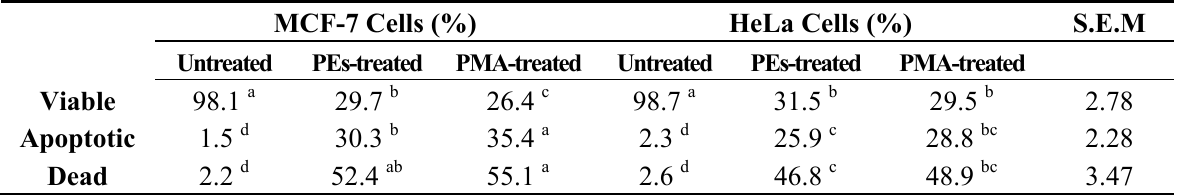
Table 2. Percentage of viable, apoptotic and dead cells analysed by flow